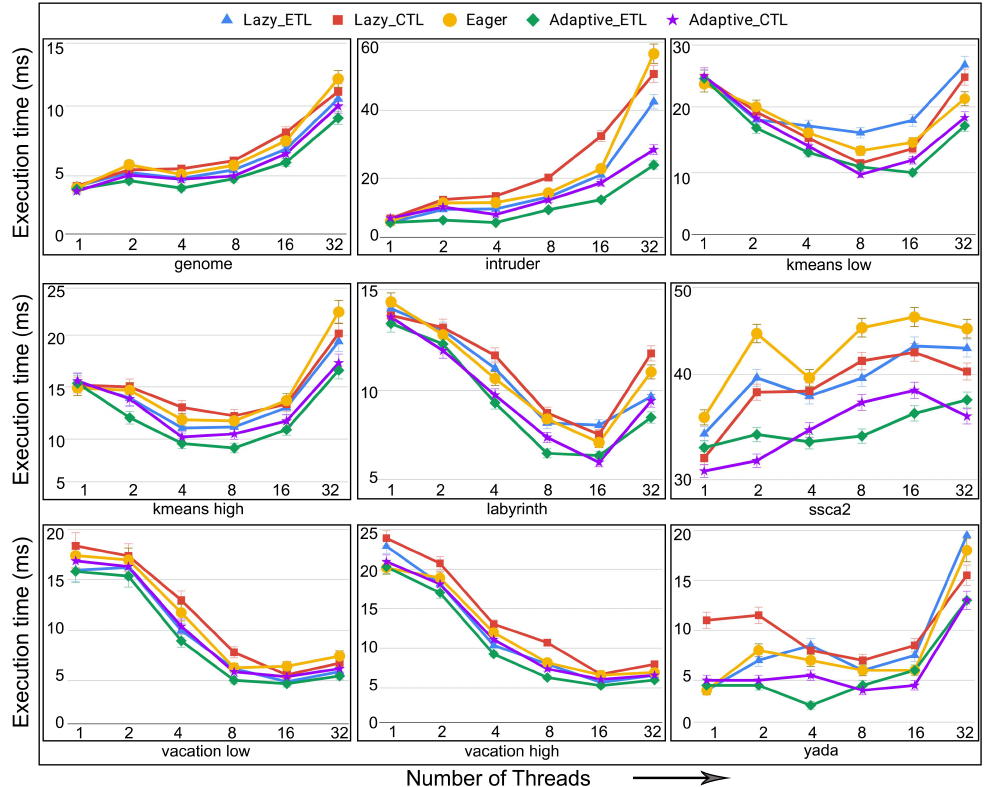
Figure 21. Execution time in STAMP benchmarks using better time barrier in non-persistent